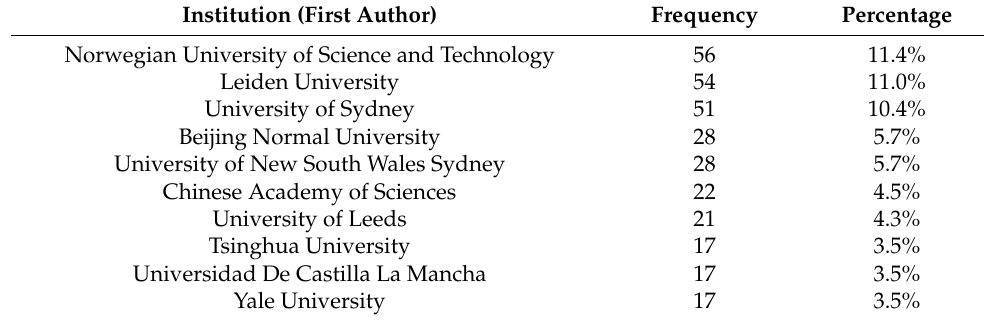
Table 3. Top 10 institutions based on frequency. Table 1. Top 10 authors based on frequency.